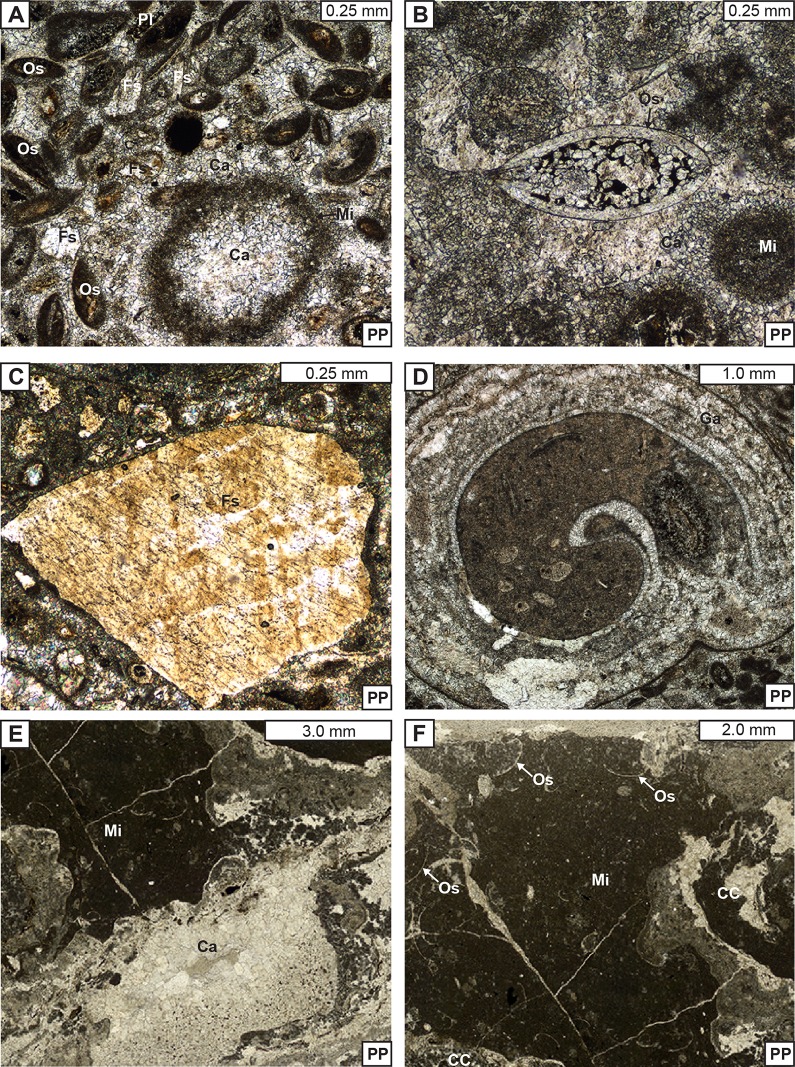
Photomicrographs of the packstone.(A) Allochems of the packstone cemented by fine-medium sparry calcite. (B) Intact ostracod allochem. (C) Detrital feldspar. (D) Gastropod. (E) Contast showing massive micrite matrix and various-sized calcite cement of packstone. (F) Massive micrite matrix. CC-caddisfly case; Fs-feldspar; Os-ostracod; Ga-gastropod; Ca-calcite; Mi-micrite; Pl-plant fragment.